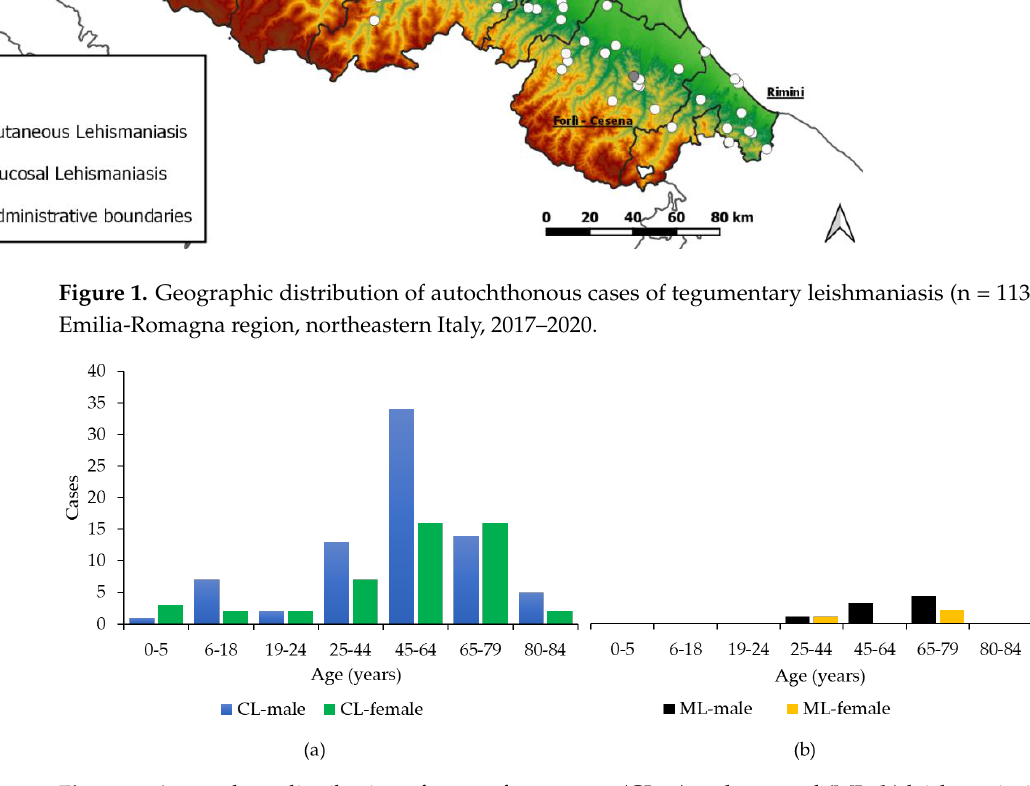
Figure 2. Age and sex distribution of cases of cutaneous (CL, a ) and mucosal (ML, b ) leishmaniasis (n = 135), Emilia-Romagna region (northeastern Italy), 2017 – 2020.